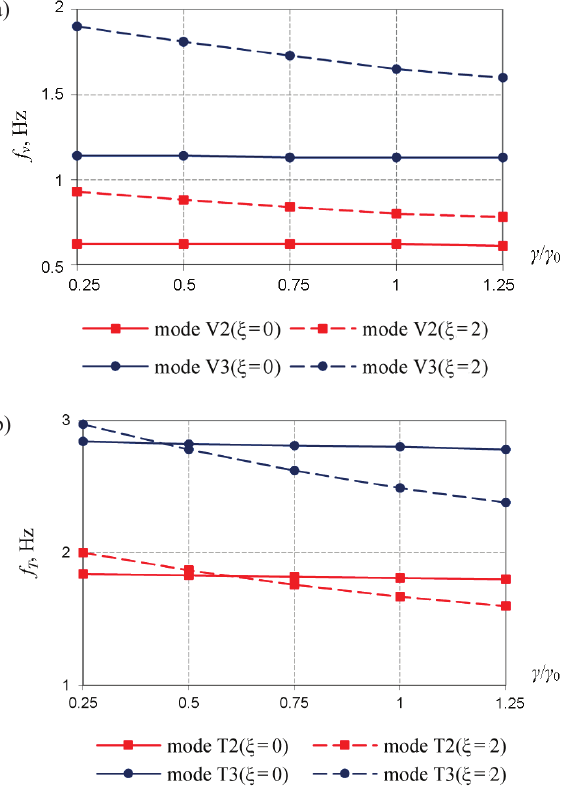
Fig. 9. The effect of the ratio γ / γ 0 of the mass density of the cable on the lowest two natural frequencies of vertical (a) and torsional modes (b) considering two values of stiffness parameters ξ = 0 and ξ = 2.0 of the